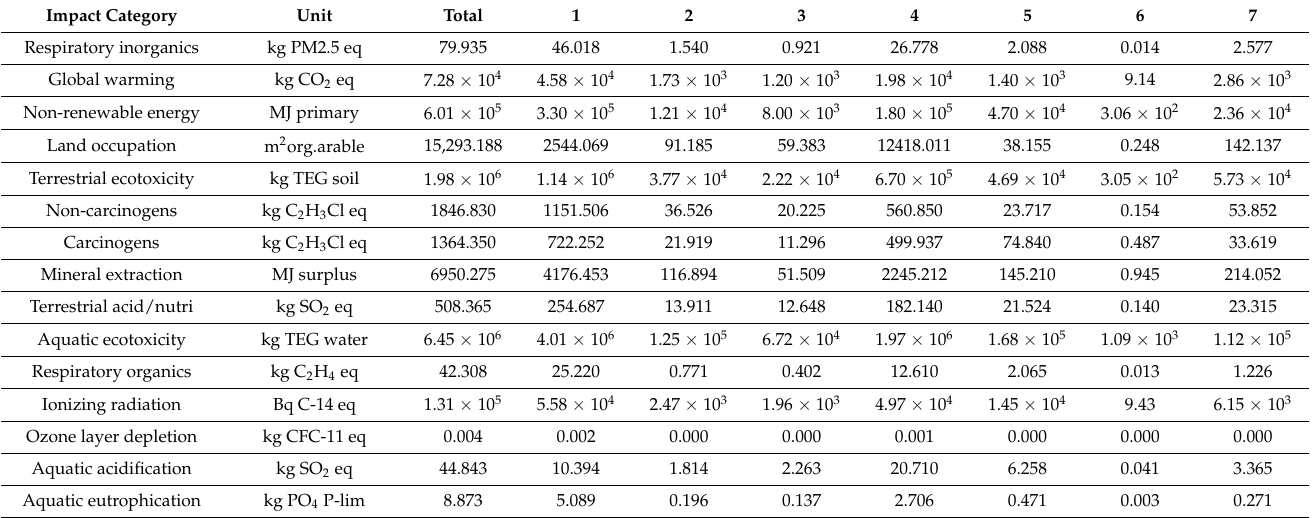
Table 3. WCB characterization, midpoint categories, SimaPro, IMPACT 2002+: 1. Abutments and piers, 2. Capping beam, 3. Abutment wall, 4. Main construction and bridge deck, 5. Bridge bearing, 6. Bridge top, 7. Bridge